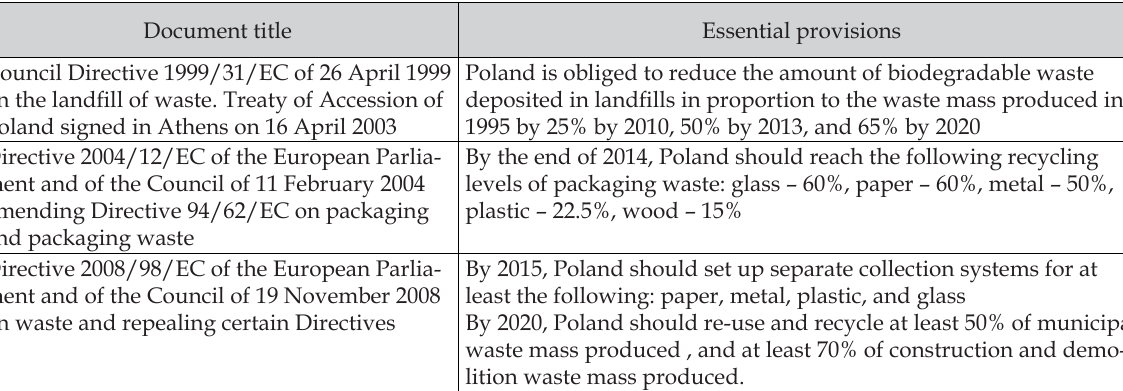
Table 3. Poland’s institutional obligations concerning changes in waste management following from EU